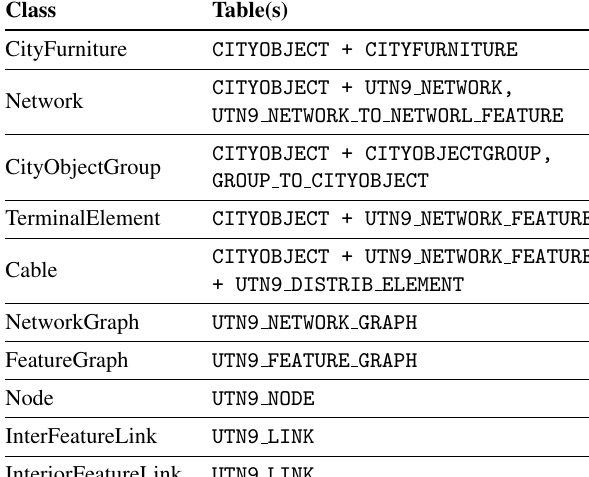
Table 1. CityGML classes and corresponding table names in